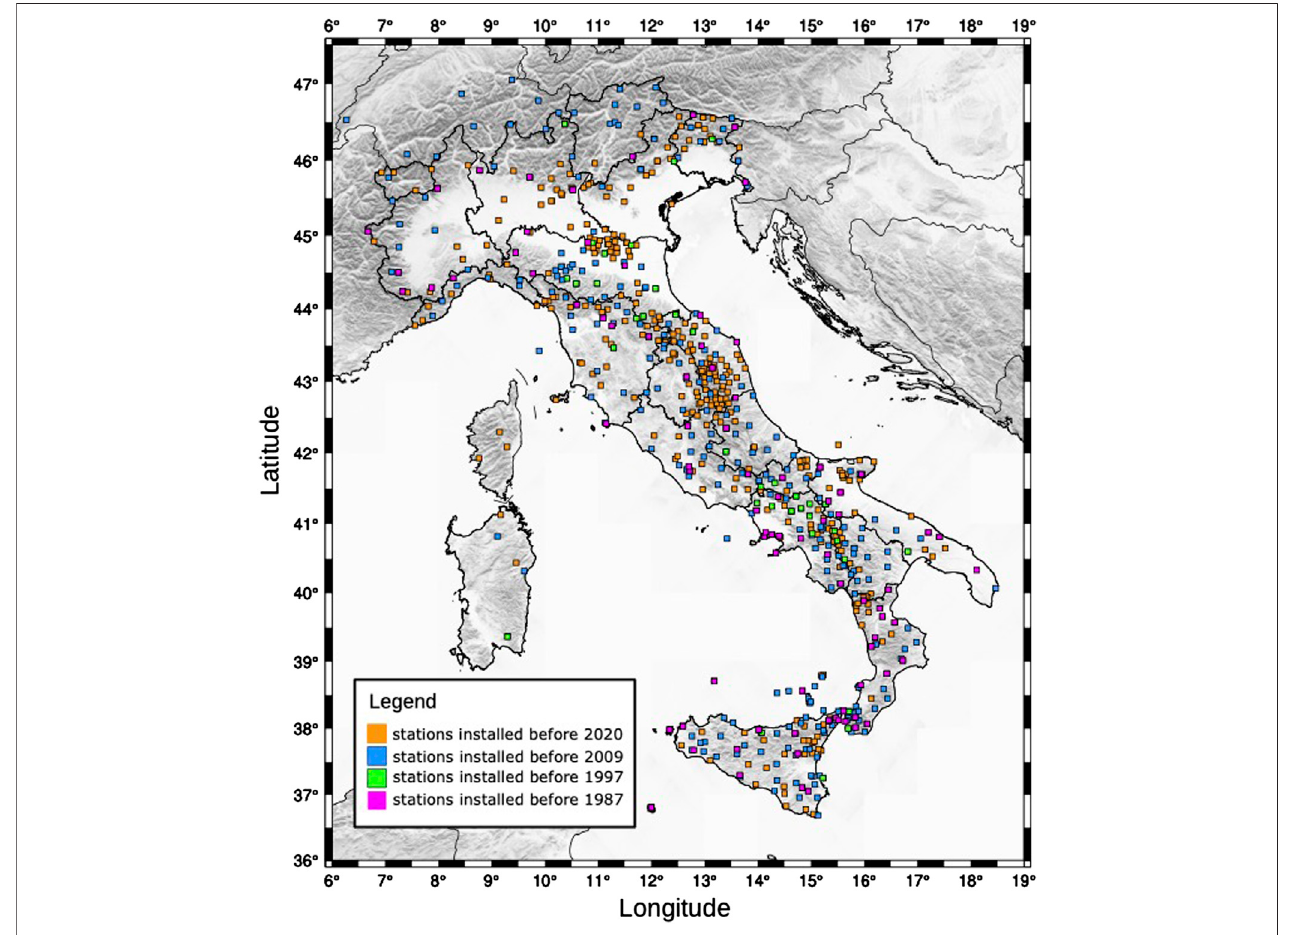
FIGURE 2 | Temporal evolution of the deployment of monitoring seismic stations in Italy, maintained by various Italian and international institutes and universities (see the text for details). Substantial increases in the number of stations concurred with the occurrence of different seismic sequences.